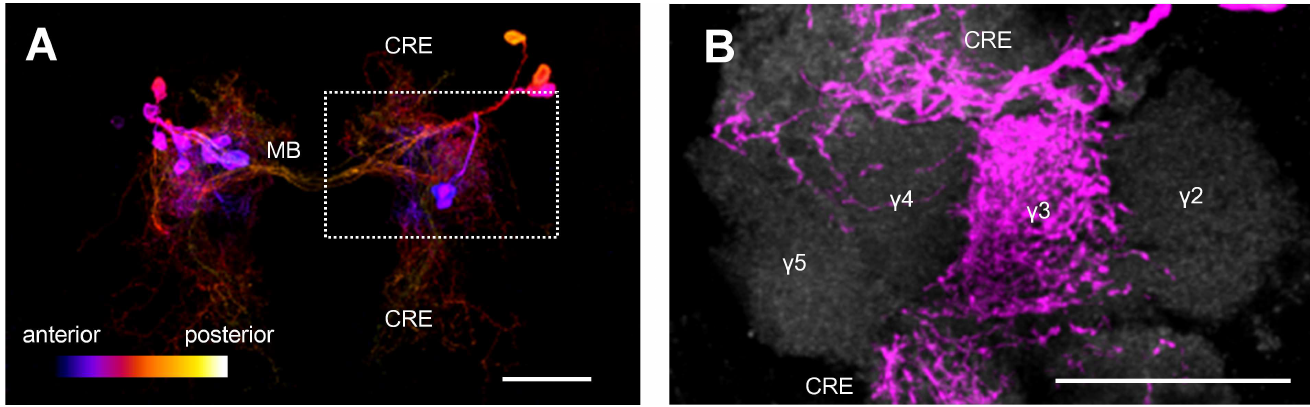
Fig 1. PAM- γ 3neurons specifically innervate the γ 3 domain of the MB. (A) MB441B-GAL4 specificallylabels PAM- γ 3in the brain. (B) Magnification of the inset in A. The γ lobe is visualized with n-Cadherin (gray). CRE: crepine. Scale bars, 20 μ m.